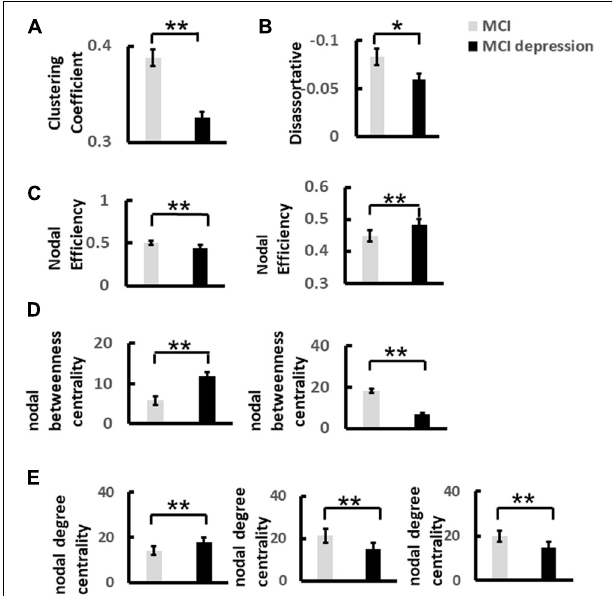
FIGURE 6 | The significant difference of global and nodal network metrics for each group during the Emotion Regulation task. (A) Demonstrates the significant difference of Clustering Coefficient of alpha band over frontal lobe between MCI and MCI depression group. (B) Illustrates the significant difference of Disassortative of alpha band over frontal and parietal lobes between MCI and MCI depression group. (C) Illustrates the significant difference of Nodal efficiency of alpha band between MCI and MCI depression group. (D) Illustrates the significant difference of Nodal degree centrality of alpha band over frontal, parietal and occipital lobes between MCI and MCI depression group. (E) Demonstrates the significant difference of nodal betweenness centrality of alpha band over frontal, parietal and occipital lobes between MCI and MCI depression group * p < 0.05, ** p <